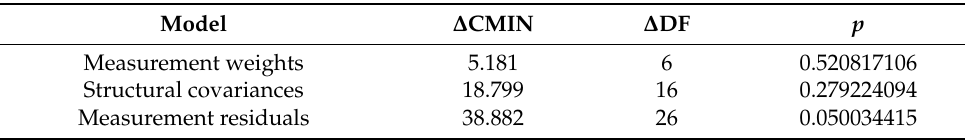
Table A5. Direct, indirect, and total effects of livelihood capitals and human settlements on